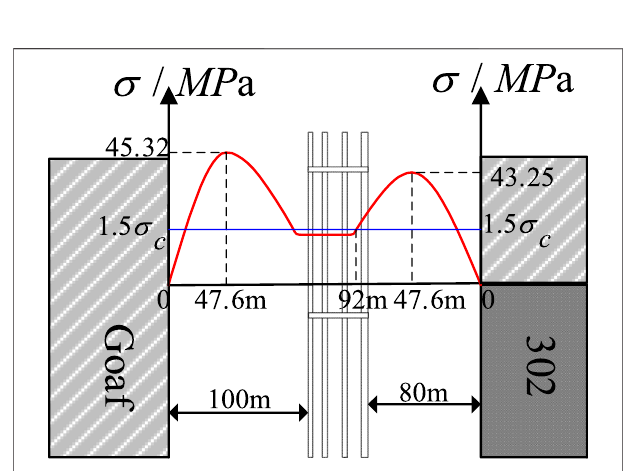
FIGURE 12 | Effect of the supporting stress in the goaf on both sides.